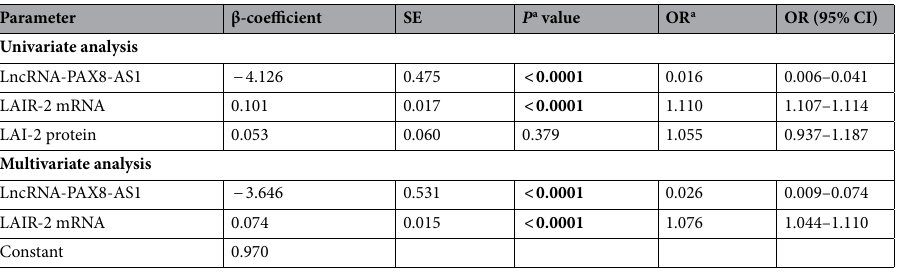
Table 6. Logistic regression analysis to predict the risk of clinical hypothyroidism. Clinical hypothyroidism (n = 100) versus healthy control + subclinical hypothyroid group (n = 205). Log likelihood of the stepwise multivariate logistic regression model = − 107.847, − 2 Log likelihood = 215.694, P < 0.0001. P values in bold means statistical significance between groups, P < 0.05. a adjusted for age and